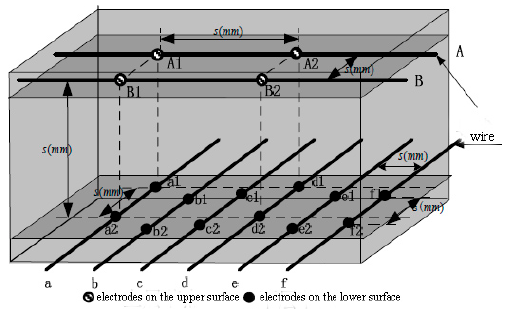
Figure 1. The structure of the sensor nodes array.